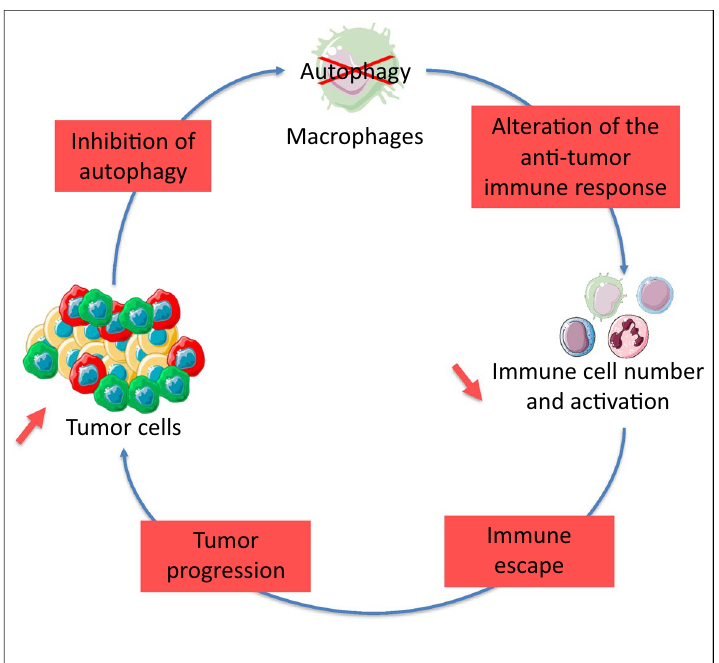
Figure 8. Schematic representation of the vicious circle in which inhibition of macrophage autophagy by tumoral cells could promote escape of HCC to antitumor immunity. Tumor cells inhibits